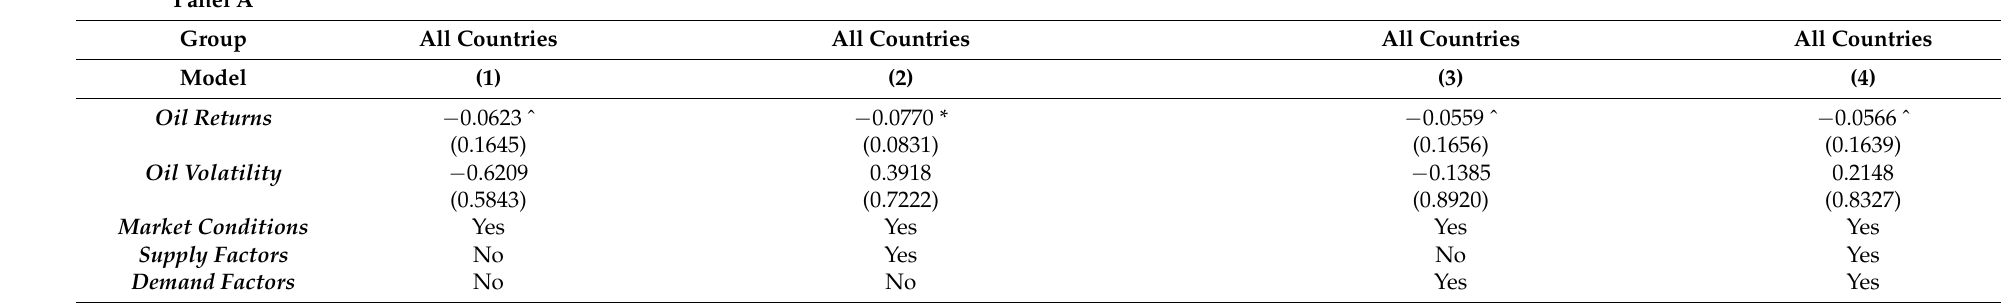
Table 8. Robustness Check. This table reports the results of including orthogonal oil factors in the SUR. Oil factors are orthogonalized by taking the residuals from the regressions of oil factors on market factors. Panel A validates the results presented in Table 3. Panel B validates the results presented in Table 4. Panel C validates the results presented in Table 5. Panel D validates the results presented in Table